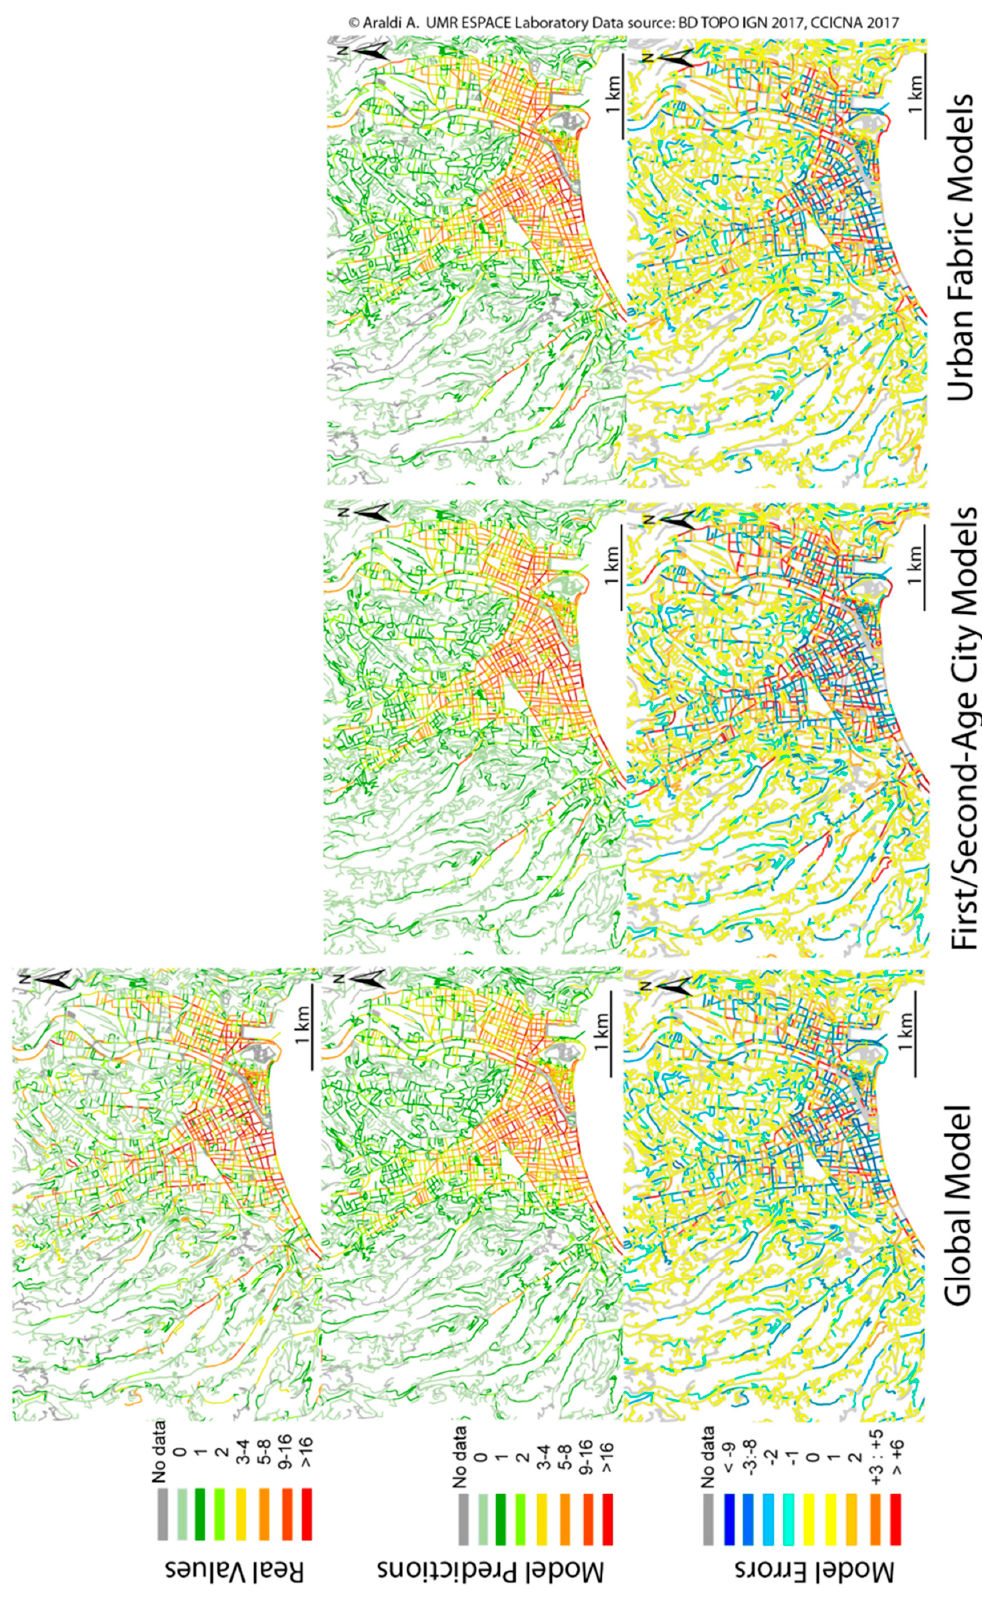
Figure 3. Projection in the geographical space of the observed, predicted and residual values for the global model, First/Second-Age City and urban fabric composite models.